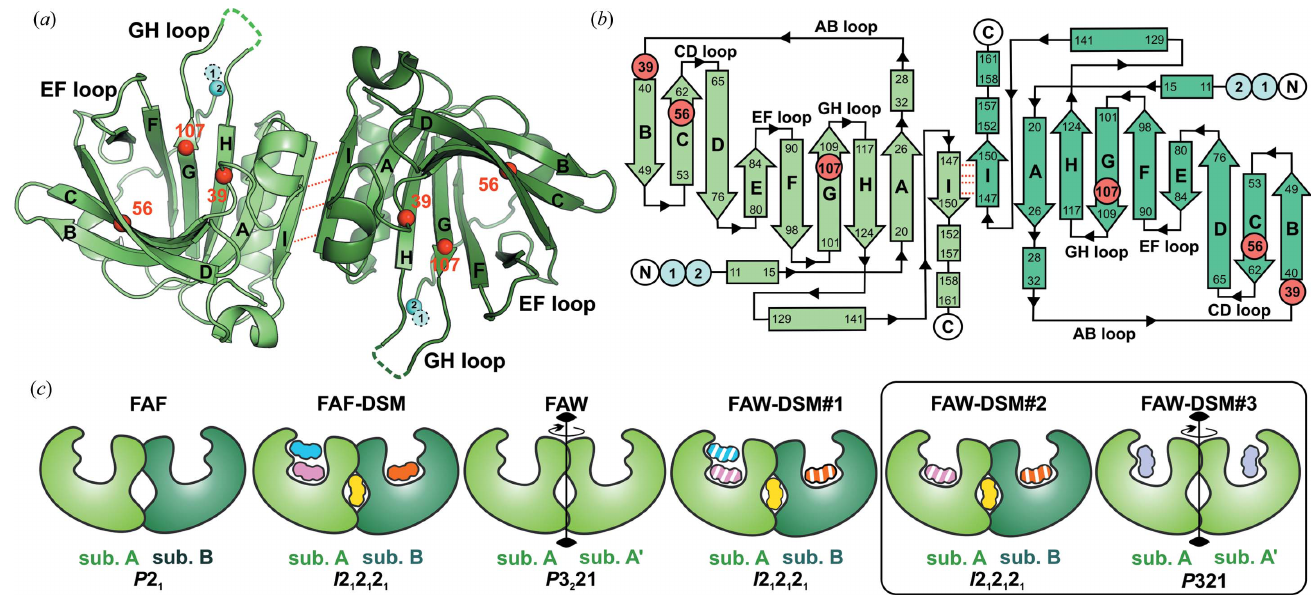
Figure 1 ( a ) Structure of the lactoglobulin homodimer with the mutation sites L39A, I56Fand M107F (or M107W) marked by red spheres; cyan spheres mark the N-terminal L1A/I2S substitutions. The dimer subunit A (chain A ) is colored light green, while subunit B (chain B ) is in dark green. ( b ) Topology diagram of the BLG homodimer with mutation sites marked as in ( a ) and with labels for (cid:2) -strands (arrows) A–I and for the following strand-connecting loops: AB, CD, EF and GH. (cid:4) -Helices are marked as rectangles without labels. In ( a ) and ( b ) the hydrogen bonds responsible for dimerization are marked by red dotted lines. ( c ) The green shapes represent BLG dimer subunits (light green, chain A ; dark green, chain B ). In FAF, FAF–DSM, FAW–DSM#1 and FAW–DSM#2 the asymmetric unit contains the BLG dimer (chain A and chain B ), while in FAW and FAW–DSM#3 the dimer is generated by a crystallographic twofold axis (chain A and symmetry-related chain A 0 ). The colored shapes represent DSM molecules: DSM I (pink), DSM II (cyan), DSM III (yellow), DSM IV (orange) and the single DSM in FAW–DSM#3 (blue). Ligands with fractional occupancy are marked with white stripes. Crystals of FAW–DSM#2 and FAW–DSM#3 grew simultaneously in the same crystallization drop (black frame). Space-group symbols are given at the bottom of ( c